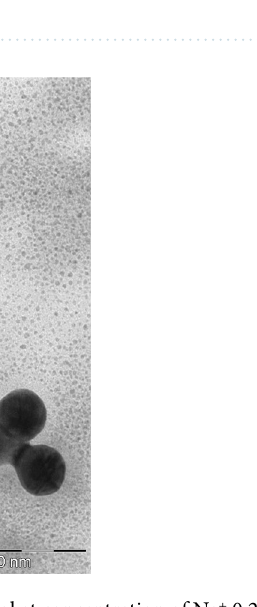
Figure 12. TEM image of a positive Se NPs sol at concentration of Na + 0.25 M (magnification ×